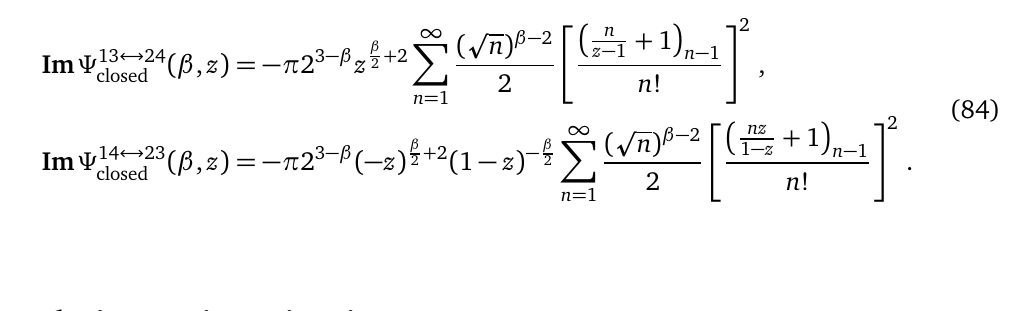
Figure 4: Here we present the comparison of numerical evaluation of Mellin integral and residue sum formula eq.(83) for the imaginary part of celestial closed string amplitude. LHS and RHS shows the behavior of Im Ψ 12 ↔ 24 z → 1 The comparison with result from the numerical integral is given in figure 4. Similar with the open string, the divergences in the z → 1 and z → ∞ limits are implied by the massless t , u